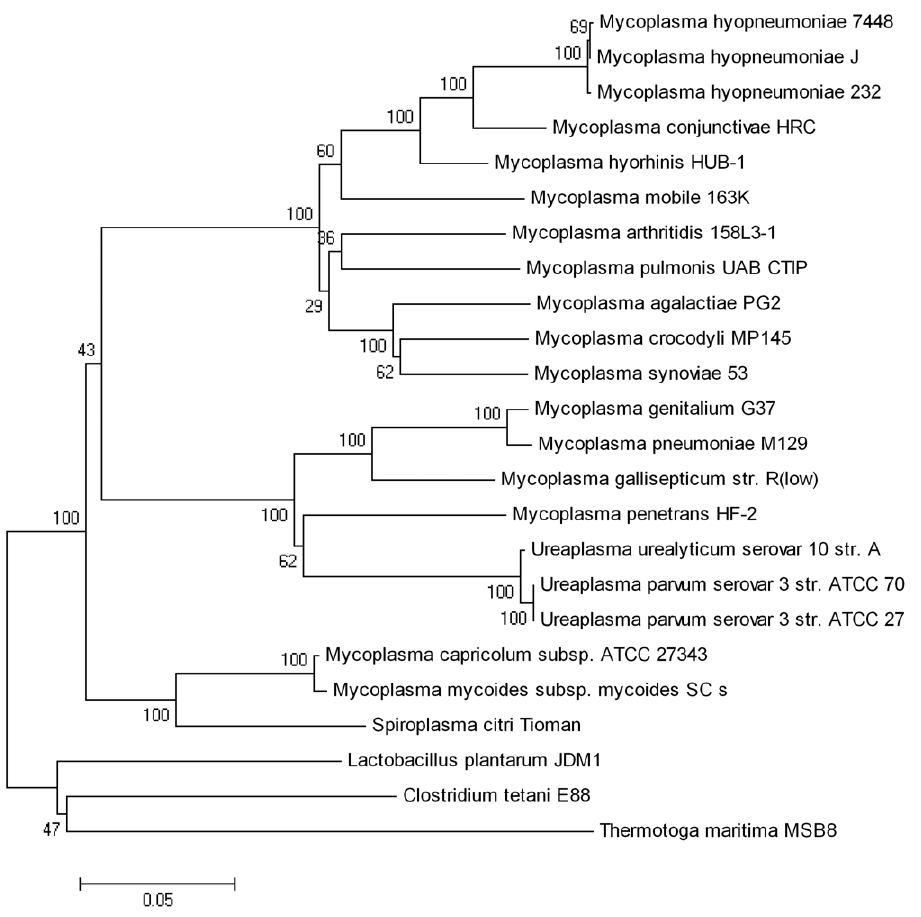
Figure 5. 16S rRNA tree of Mycoplasmataceae . This consensus tree of 100 bootstrap replications was constructed based on 16S rRNA sequences using the Neighbor Joining (NJ) method implemented in MEGA 4.1. The bootstrap values are marked at the root of each branch.